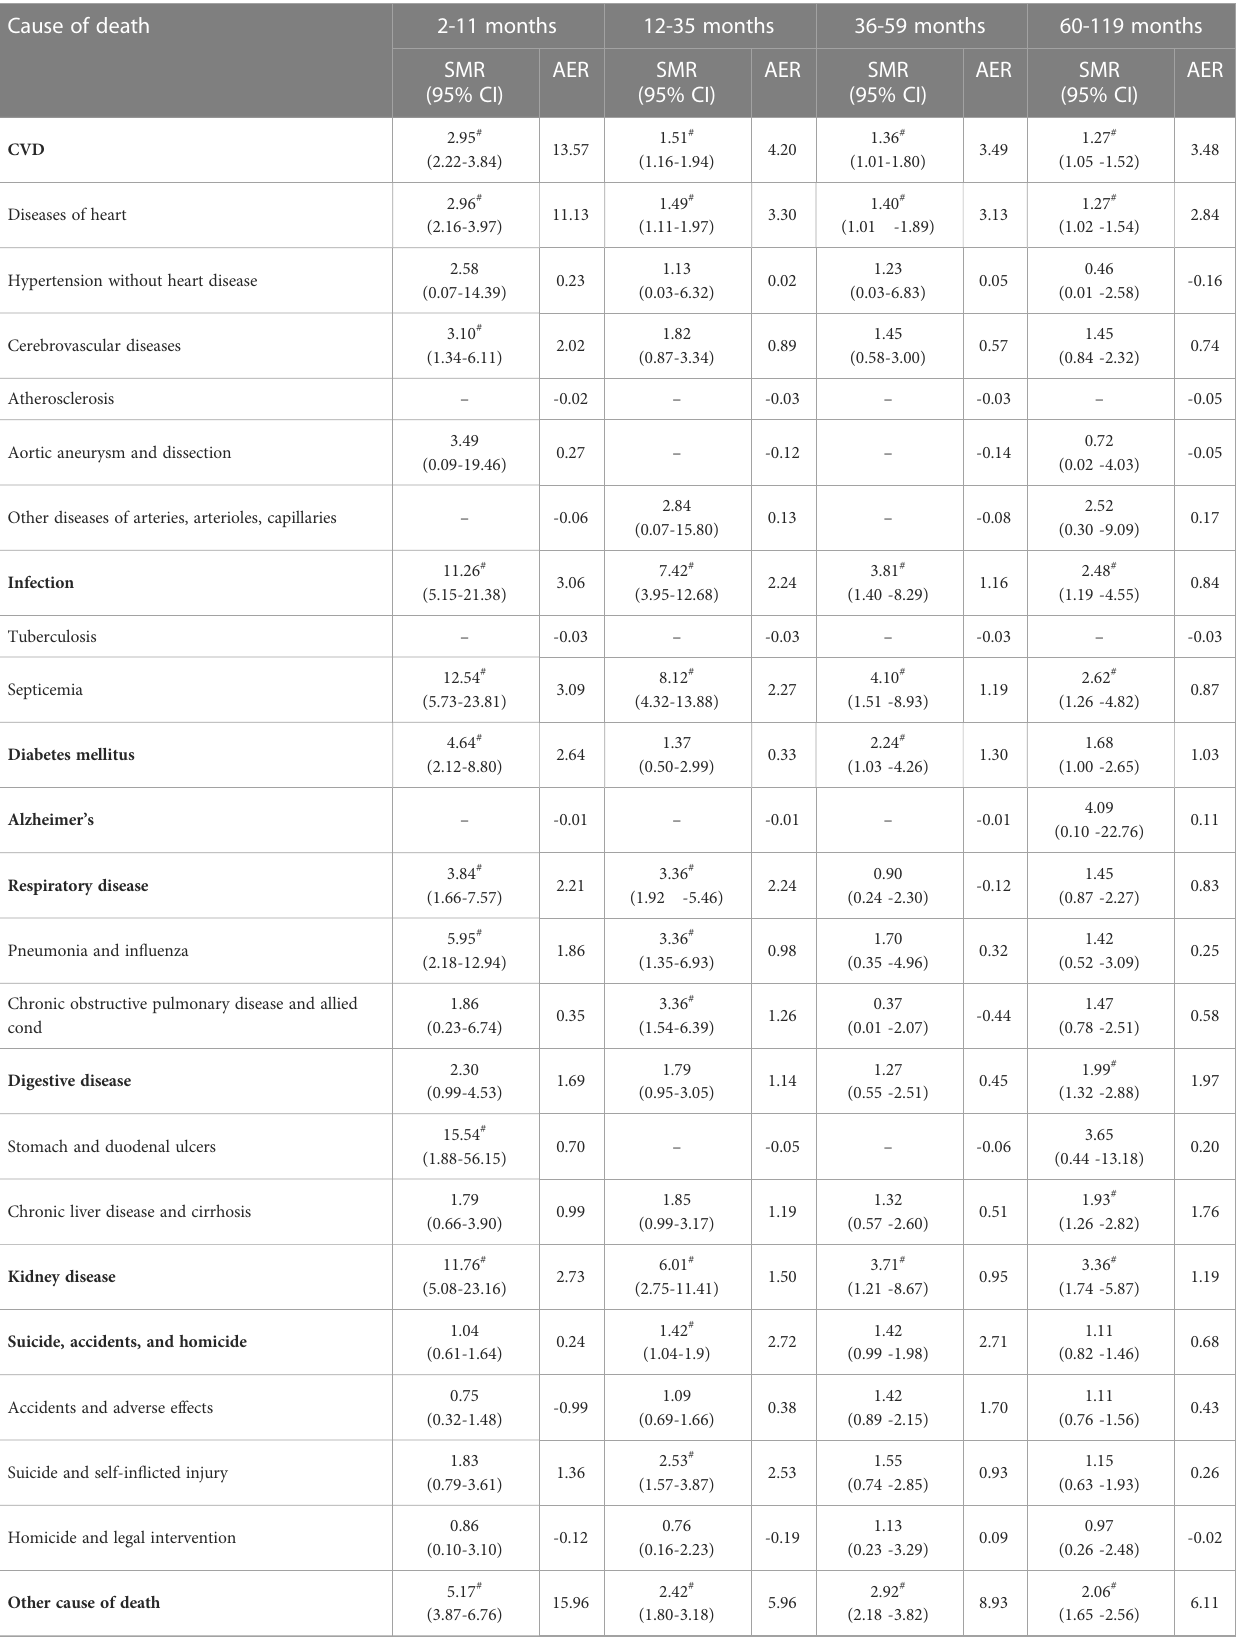
TABLE 2 Standardized mortality ratios and absolute excess risks for causes of death on different follow-up time in early-onset colorectal cancer